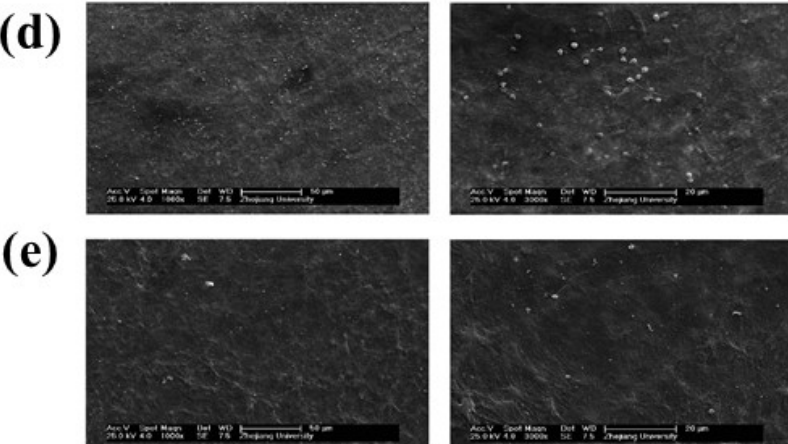
Figure 11. Unmodified and modified PE porous membrane surface platelet morphology: ( a ) initial PE membrane, ( b ) PE/dopamine composite membrane, ( c , d ) PE/dopamine-heparin composite membrane, ( c – e ). Reprinted with permission from [65].